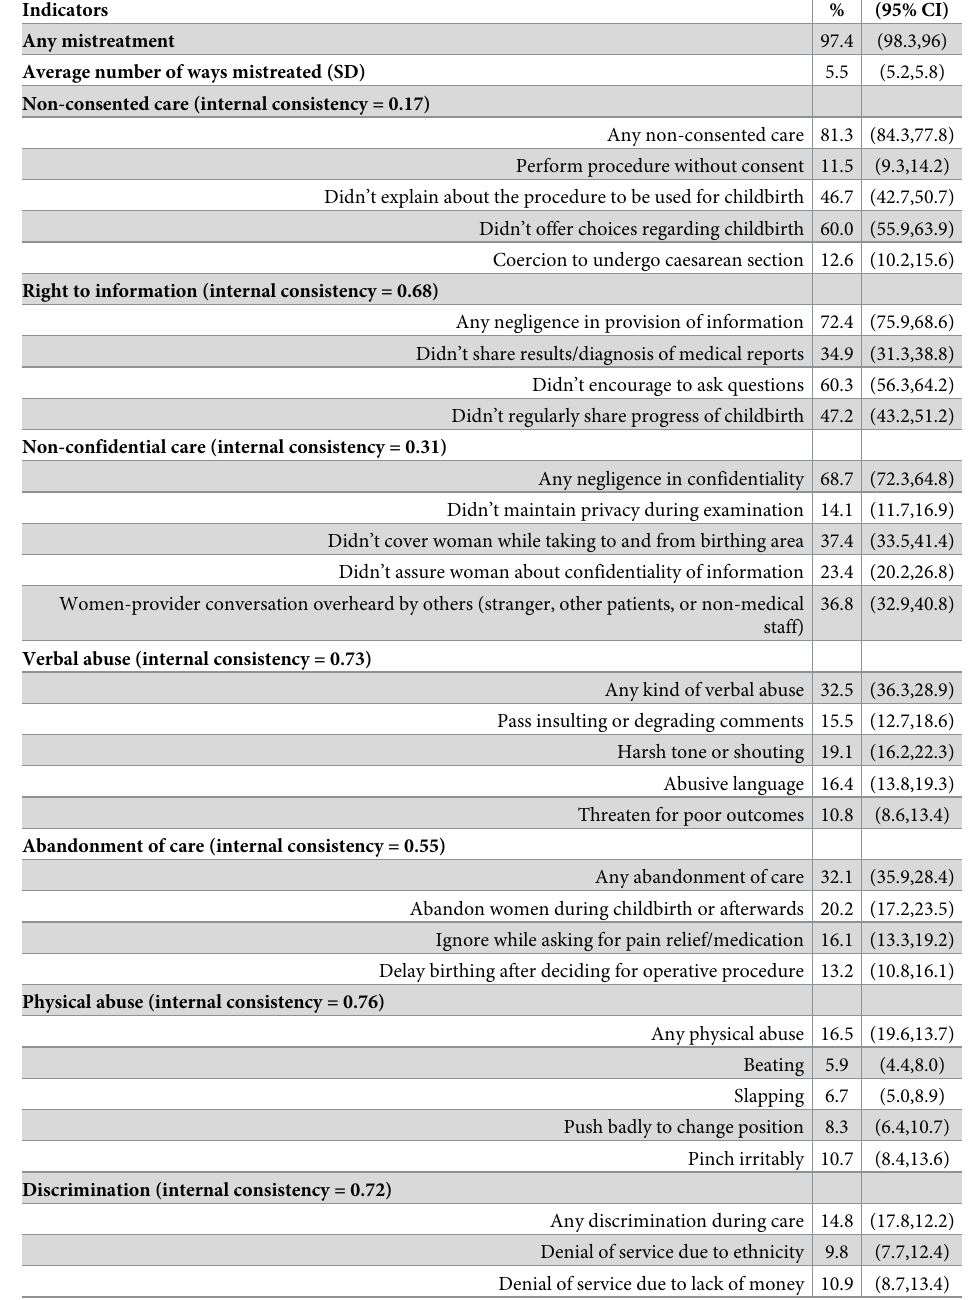
Table 2. Occurrence of mistreatment during childbirth by type.